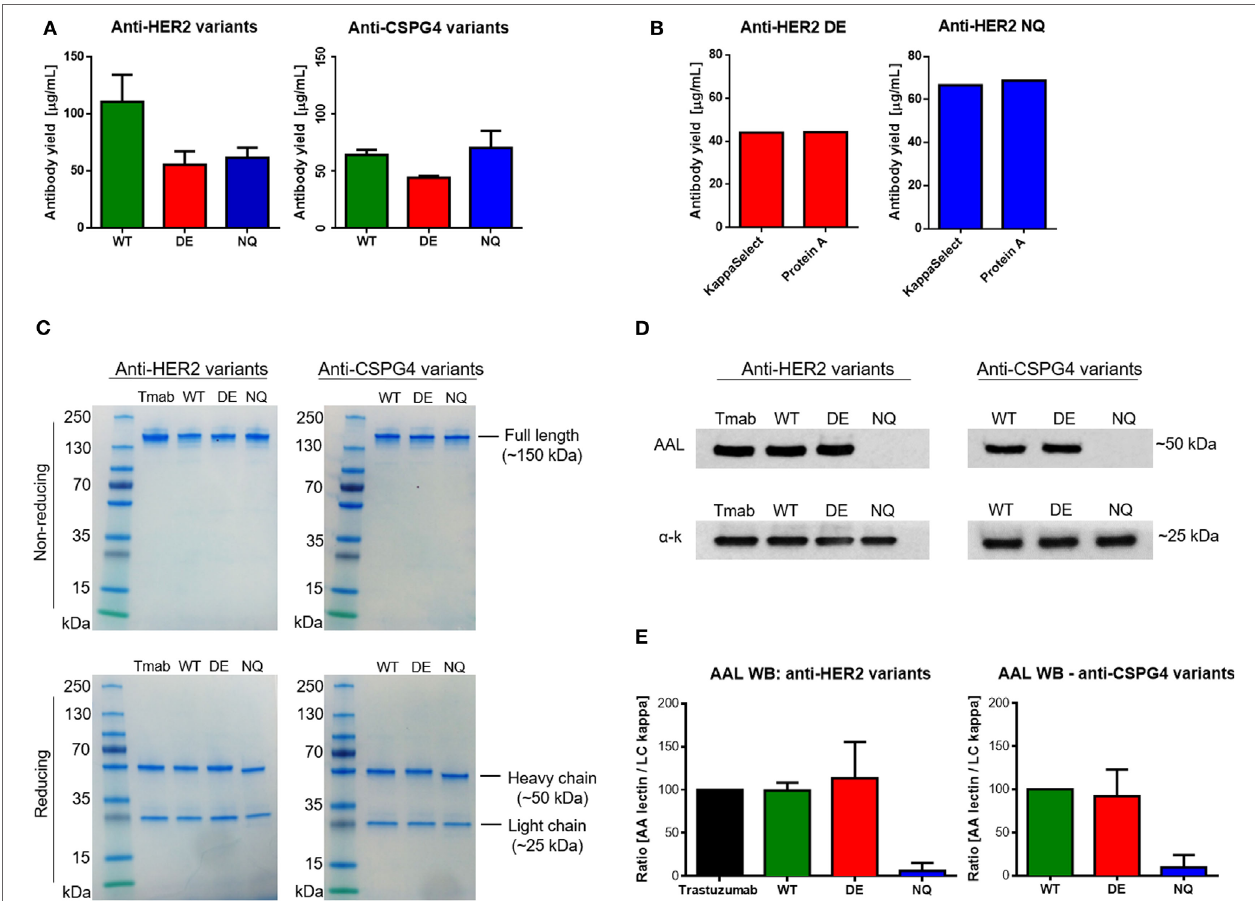
FigUre 4 | Purified antibody evaluations. (a) Wild–type (WT) and mutant anti-HER2 and anti-CSPG4 antibody yields per mL of cell culture supernatant after purification (data from two independent experiments ± SD). (b) Comparison of anti-HER2 mutant antibody yields after purification using HiTrap Kappa Select (GE Healthcare) or Protein A (Pierce ™ ) columns. (c) Sodium dodecyl sulfate polyacrylamide gel electrophoresis visualization of purified anti-HER2 and anti- chondroitin sulfate proteoglycan (CSPG4) WT and Fc mutant antibodies under non-reducing (top) and reducing (bottom) conditions. PageRuler ™ pre-stained protein ladder (Thermo Fischer Scientific) was used as molecular weight reference. Bands were visualized using InstantBlue ™ protein stain (Expedeon). (D) Aleuria Aurantia Lectin (AAL) Western blot demonstrating fucosylation patterns of anti-HER2 (top left) and anti-CSPG4 (top right) Fc variants. Anti-human kappa chain antibody was used as a loading control (bottom panels). (e) Quantification of AAL Western blot signal using the ImageJ software. The AAL signal was normalized against the signal obtained with the anti-kappa chain antibody. The ImageJ peak area value of trastuzumab (Herceptin ® , Roche) was considered a 100% and the peak area values of the other anti-HER2 variants were presented as a proportion of the first value. The values of anti-CSPG4 DE and NQ were calculated accordingly as a proportion of anti-CSPG4 WT. Data from three independent experiments ±